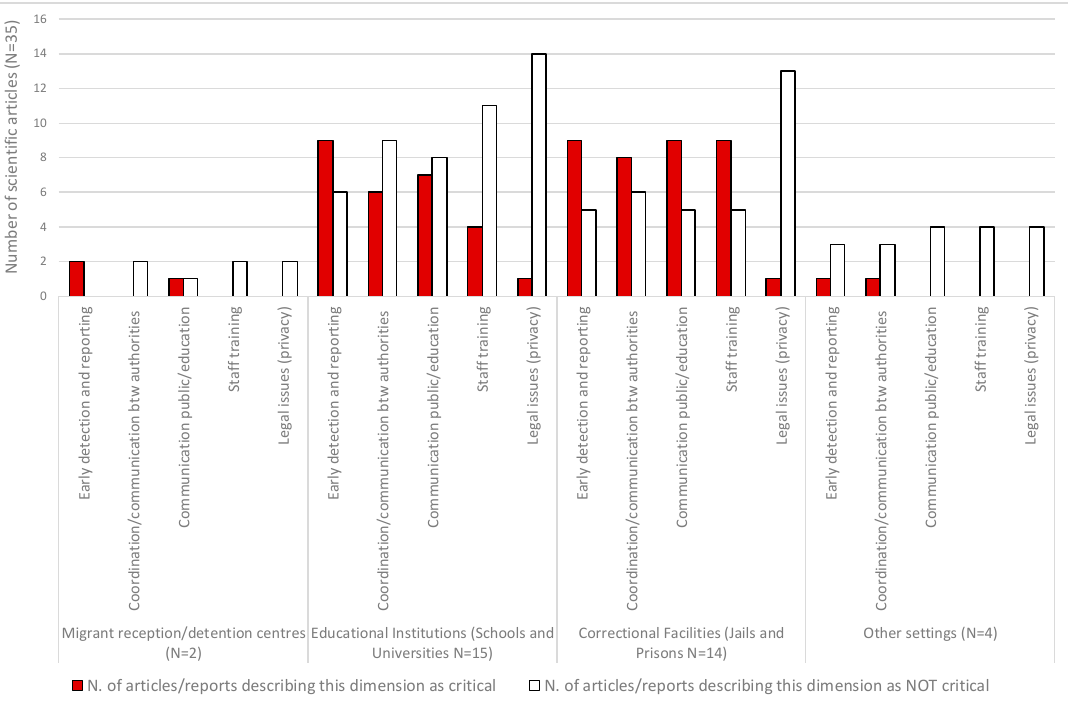
Figure 5. Number of scientific articles addressing the first review objective ( n = 35), by additional dimension and institutional setting.